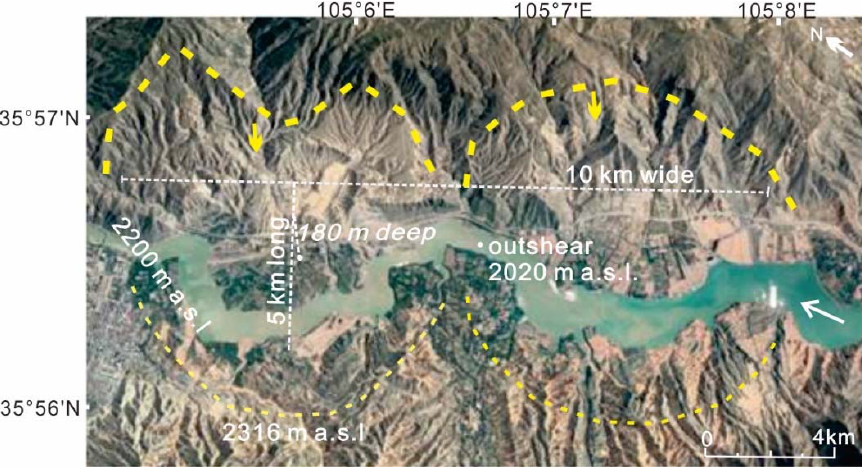
Figure 2. The scale of the Dehenglong–Suozi landslides dam from Google images. Yellow dashed curves indicate the extents of the landslides. Yellow arrows represent the source of landslide. White arrow denotes the flow direction of the Yellow River. “2316 m a.s.l.” denotes the run-up height elevation of Dehenglong–Suozi landslides on the west side of river. “2200 m a.s.l.” denotes the highest elevation of the lacustrine sediments along the Yellow River.